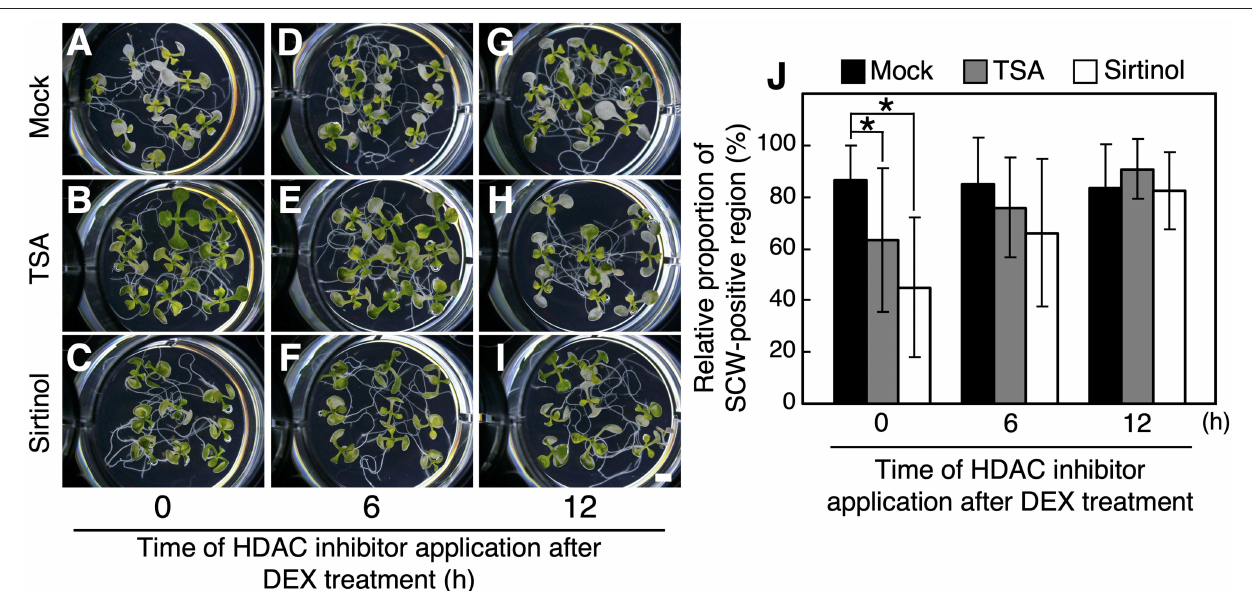
FIGURE 2 | Effects of application time of histone deacetylase inhibitors on VND7-based xylem vessel cell differentiation. Seven-day-old VND7–VP16–GR seedlings were treated with 10nM dexamethasone (DEX) without any inhibitors (A–C) , with 5 µ M trichostatin A (TSA) (D–F) , or with 10 µ M sirtinol (G–I) for 3 d. TSA or sirtinol was added at 0h (A,D,G) , 6h (B,E,H) , and 12h of DEX treatment. (J) Ectopic deposition of secondary cell walls (SCWs) in cotyledons was observed with a confocal microscope after propidium iodide staining, and the SCW-positive regions were measured in each cotyledon. The relative proportions of SCW-positive cell regions were calculated manually using an image analysis performed in ImageJ. Results are shown as means ± SD ( n > 10). Asterisks indicate statistically significant differences compare with the mock control (Student’s t -test, p < 0.05). Bar,